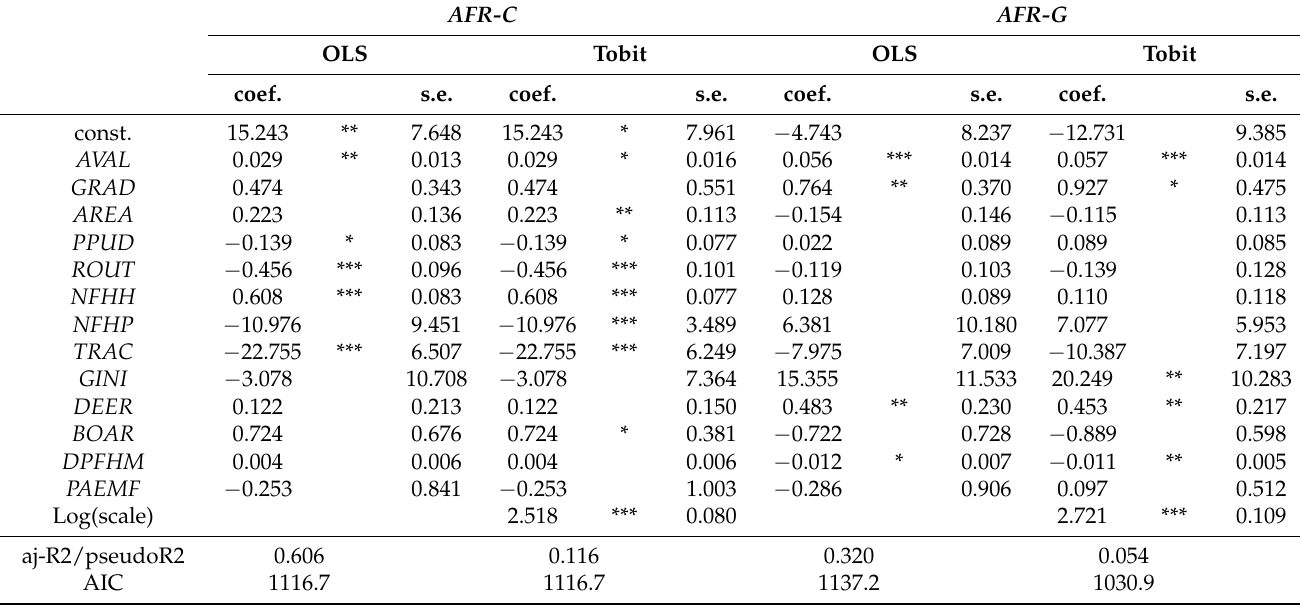
Table 2. Estimation